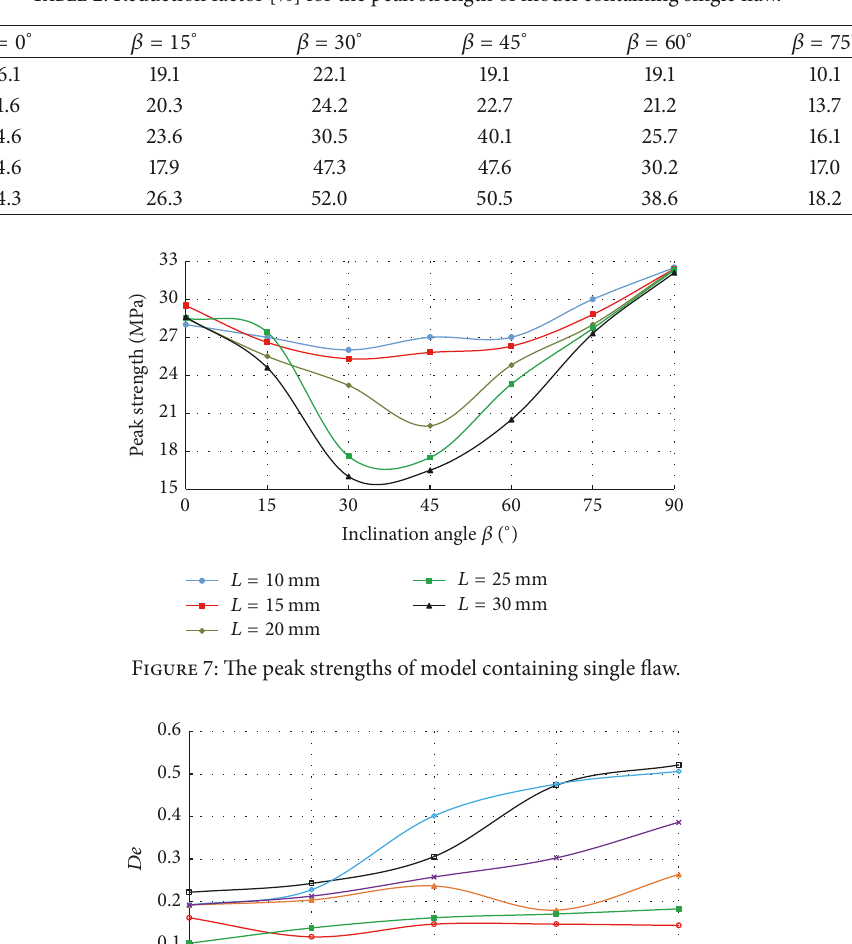
Table 2: Reduction factor [%] for the peak strength of model containing single flaw.